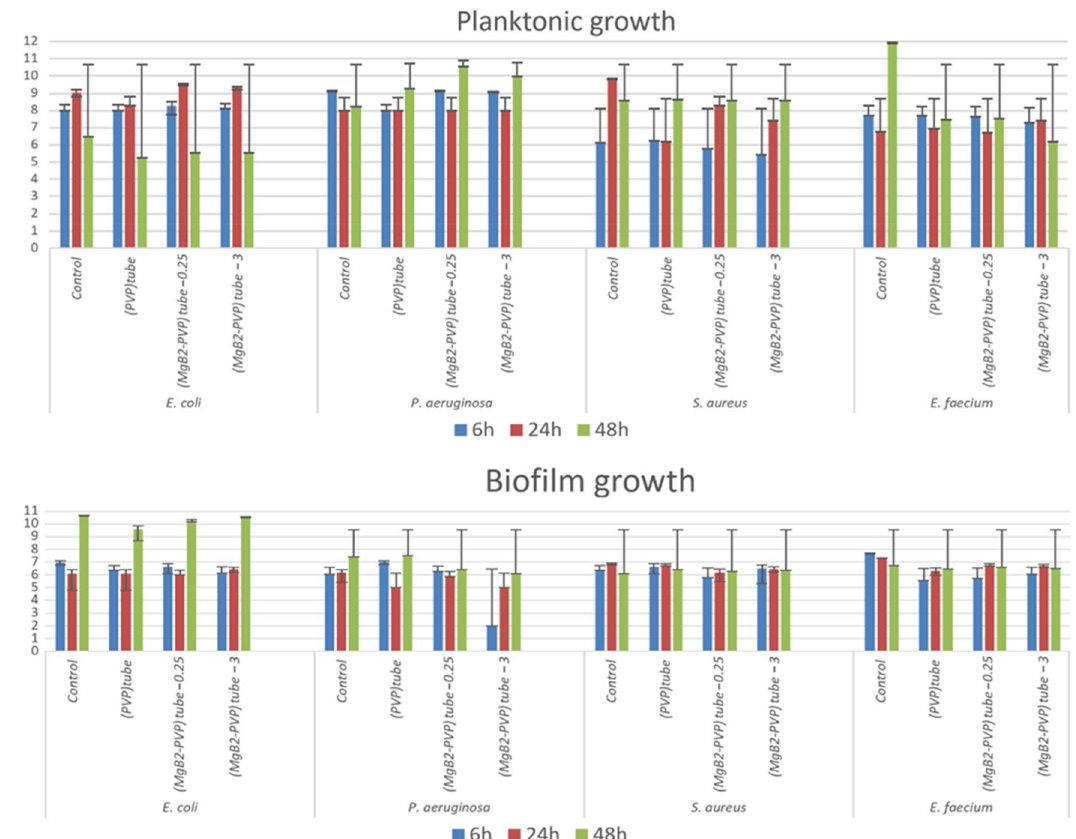
Figure 6. The number of viable of microbial cells in log 10 (CFU/ml) for samples in the form of coatings on the silicone tube (i.e. samples PVP tube , (MgB 2 -PVP) tube 0.25 , (MgB 2 -PVP) tube 3 ) tested with microbes in planktonic and biofilm